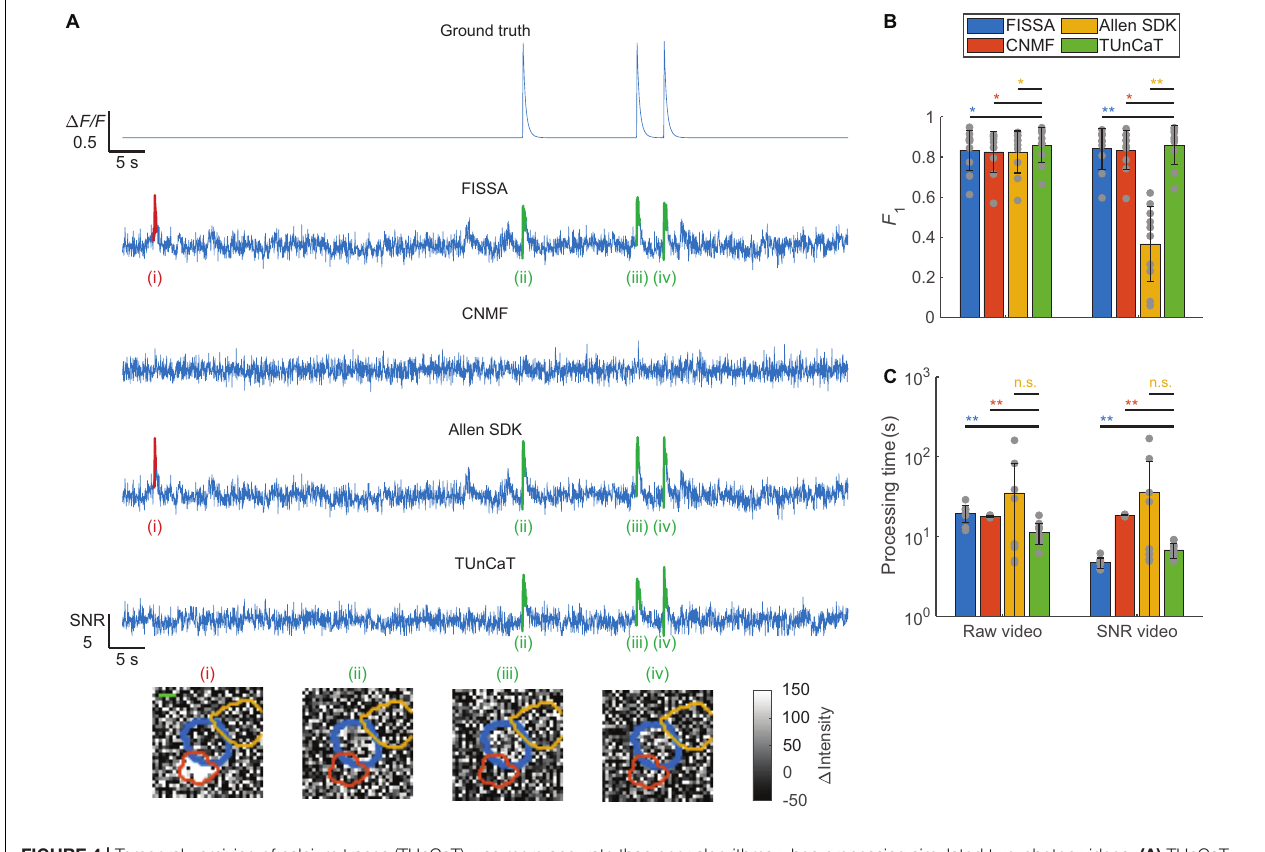
FIGURE 4 | Temporal unmixing of calcium traces (TUnCaT) was more accurate than peer algorithms when processing simulated two-photon videos. (A) TUnCaT removed false transients caused by neighboring neurons. The first trace is the ground truth trace exported from the simulation process. The four remaining traces are the unmixed traces of the neuron of interest from four different methods (FISSA, CNMF, the Allen SDK, and TUnCaT). The labels (i)–(iv) indicate examples transients correctly (green) or incorrectly (red) detected by at least one unmixing algorithm. Each image below the traces is the corresponding spatial profile of fluorescence at the peak of each transient. We subtracted the median image over time from each image to remove the static fluorescence. The thick blue contour in each image shows the boundary of the neuron of interest, and the orange and yellow contours show the boundary of two different neighboring neurons (scale bar: 5 µ m). (B) The F 1 scores of TUnCaT during 10-round cross-validation were superior to that of the other methods both when processing raw videos and when processing SNR videos (* p < 0.05, ** p < 0.005, two-sided Wilcoxon signed-rank test, n = 10 videos; error bars are standard deviations). The gray dots represent scores for the test data on each round of cross-validation. (C) The processing time of TUnCaT was comparable to or faster than the other methods both when processing raw videos and when processing SNR videos (** p < 0.005, n.s. - not significant, two-sided Wilcoxon signed-rank test, n = 10 videos; error bars are standard deviations). The gray dots represent the processing times for the test data on each round of